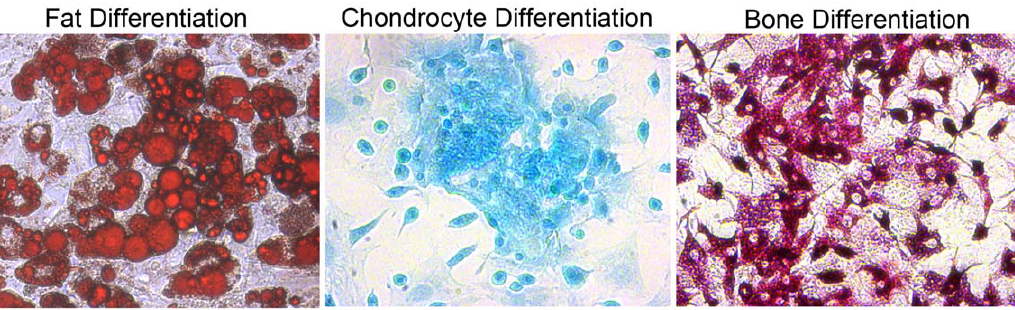
Figure 3. MSCs were functionally verified. Functional assays verified tri-lineage differentiation potential of mesenchymal stem cells after culturing for three weeks. Adipogenic differentiation was verified by staining with Oil Red-O; lipid droplets stained a red color. Chondrogenic differentiation was verified by staining with alcian blue; matrix sulfated proteoglycans stained a turquoise blue color. Osteogenic differentiation was verified by alkaline phosphatase staining; osteogenic cells stained a deep fuschia color.